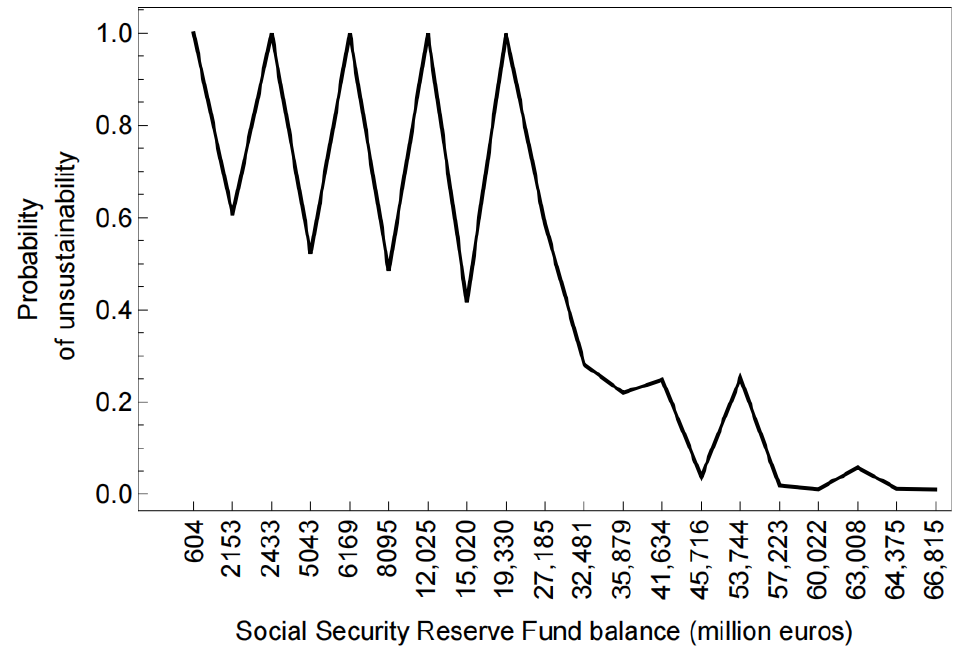
Figure 3. Probability of unsustainability. Source: Devised by the